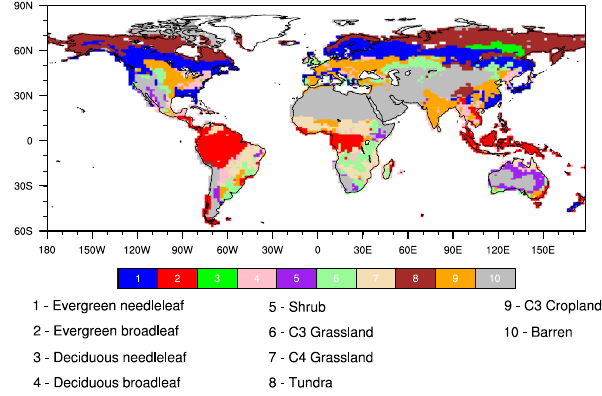
Figure 1. Distribution of dominant PFTs across the model